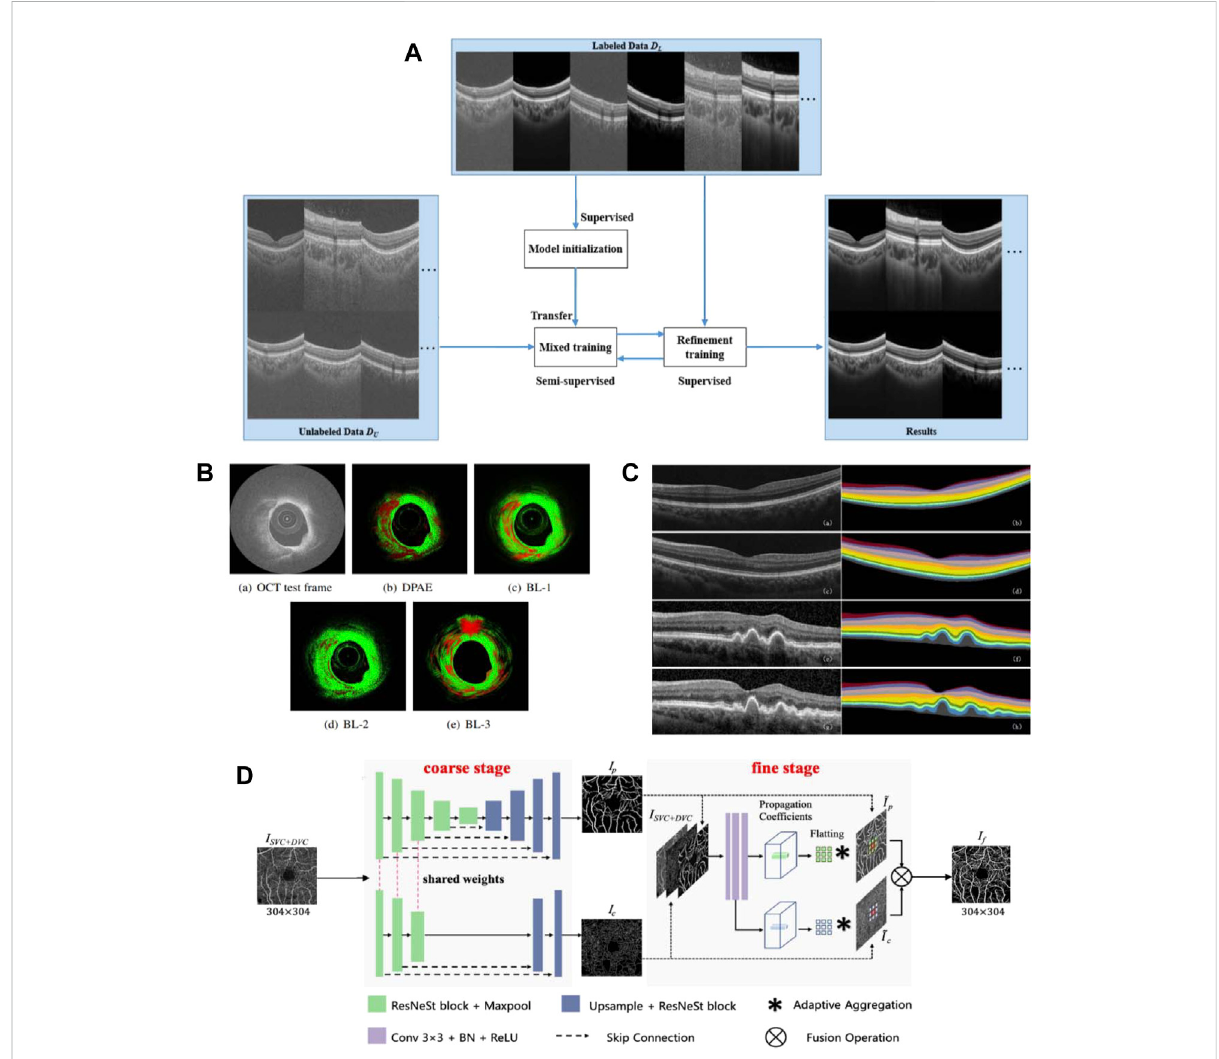
FIGURE 10 Related achievements of AI processing OCT images. (A) structure of the proposed semi-supervised system (adapted and modi fi ed from Wang etal.,2021). (B) Theresultofplaquedetection,theredarearepresentsthedetectedplaque,andthegreenarearepresentsthenormaltissue(adapted and modi fi ed from Roy et al., 2016). (C) Retinal 10-layer segmentation prediction results, The left is the original image, the right is the segmentation result (adapted and modi fi ed from Li et al., 2019). (D) Architecture of the proposed OCTA-Net network (adapted and modi fi ed from Ma et al.,